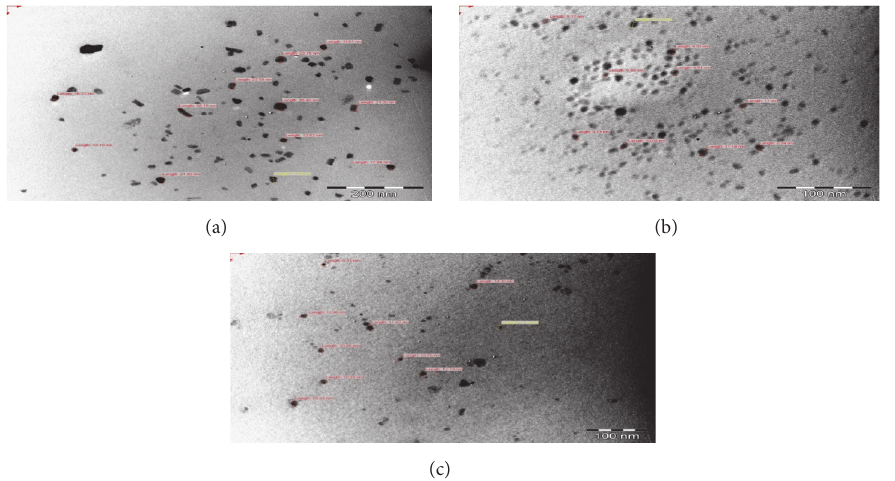
Figure 6: TEM image of NiS1 (a), NiS2 (b), and NiS3